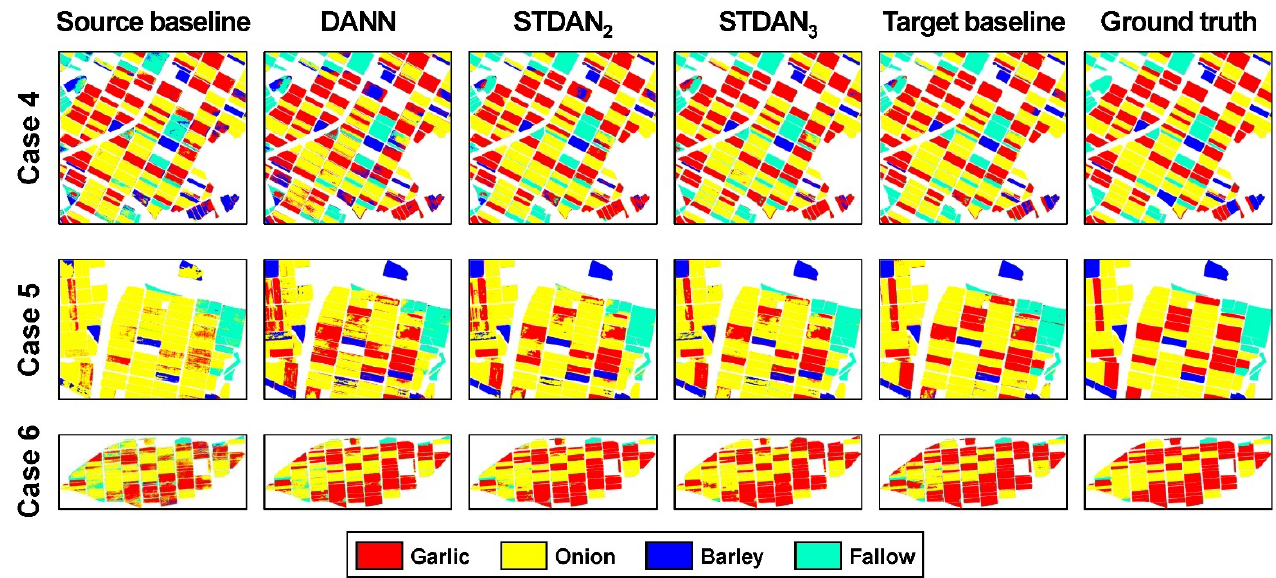
Figure 11. The five classification results for cases 4, 5, and 6 as well as the ground truth data in